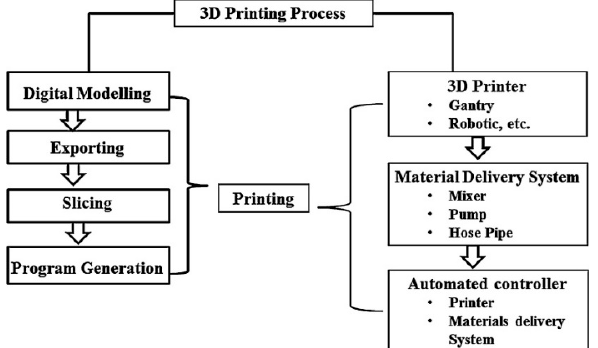
Figure 2. Additive manufacturing for construction industry (Reproduced with permission from: [7], Archives of civil and mechanical engineering; published by Science Direct, 2018).